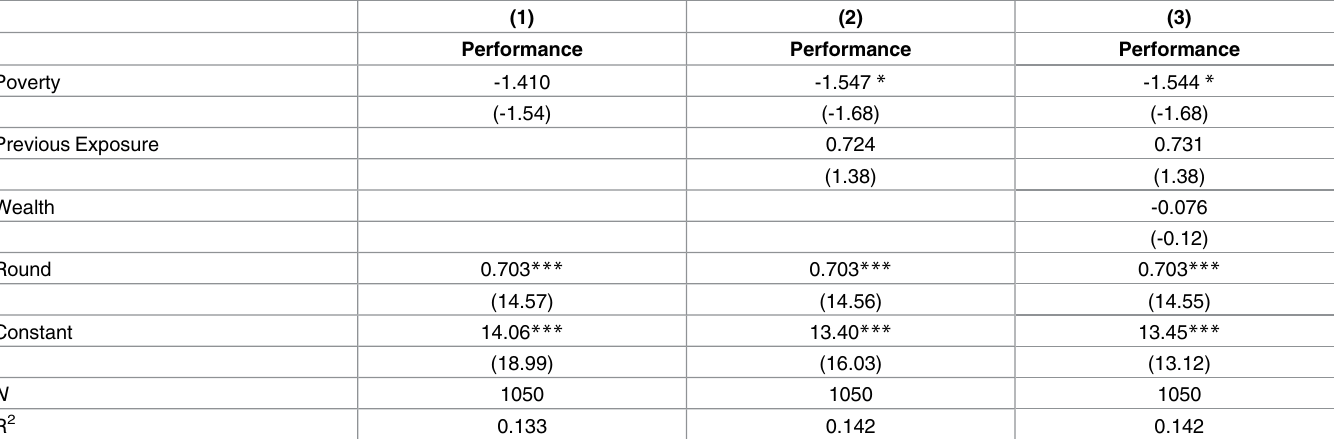
Table 1. Linear Regression of Performance on Treatment, Round and Control Variables.